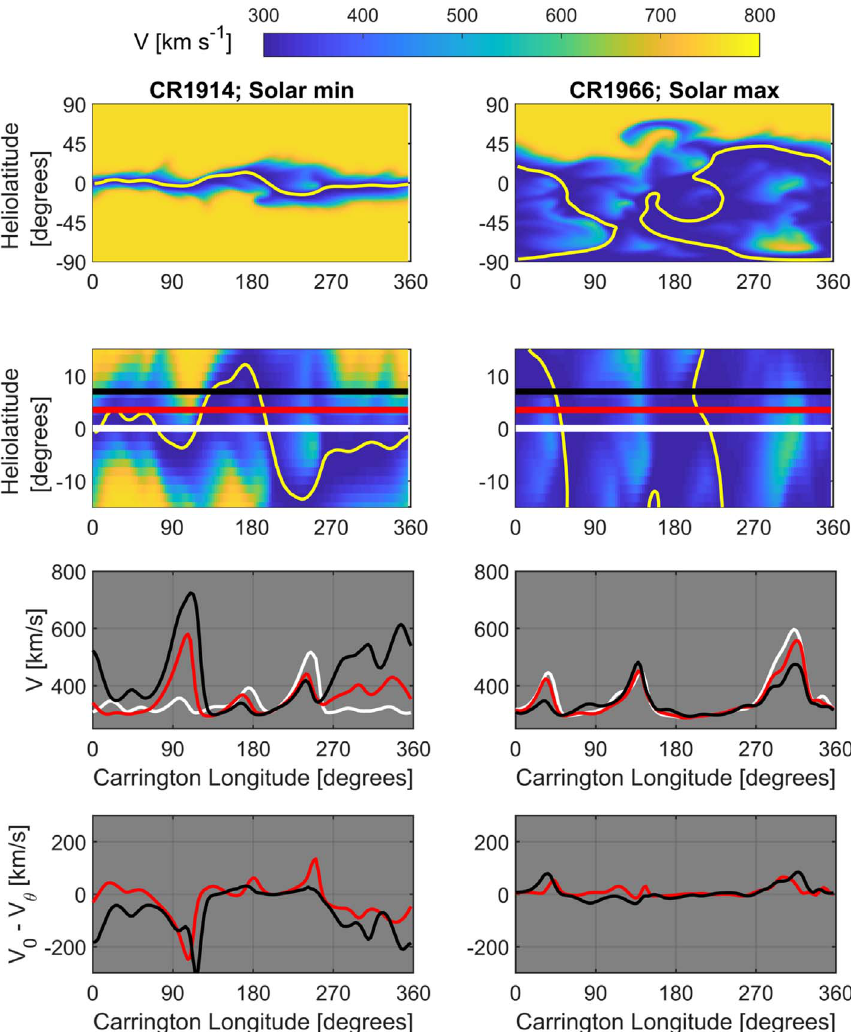
Fig. 1. Examples of model 1-AU solar wind structure at solar minimum (left) and solar maximum (right). Top: solar wind speed at 1 AU as a function of latitude and longitude. The yellow curve shows the heliospheric current sheet. Second row: same as top, but a zoom in of 15 (cid:1) about the heliographic equator. White, red, and black horizontal lines show 0 (cid:1) , 3.5 (cid:1) , and 7 (cid:1) latitude, respectively. Third row: solar wind speed at the three highlighted latitudes, in the same format. Bottom: the difference in solar wind speed between a given latitude and the equator. Figure adapted from Owens et al.